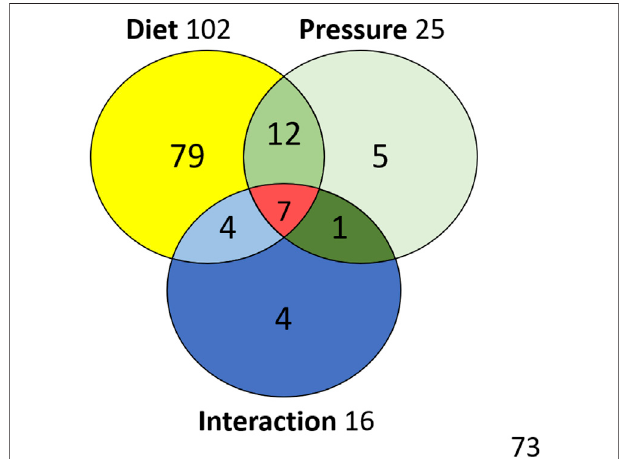
FIGURE 7 | Venn diagram with metabolites in fl uenced by diet or exposure to pressure, and their interactions.